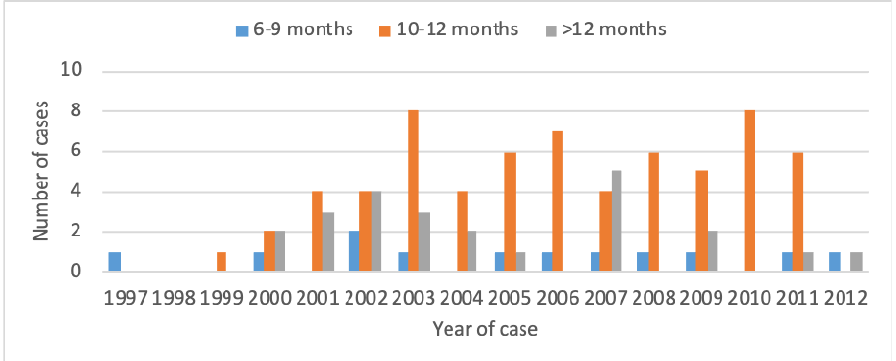
Figure 3. The distribution of patients with regard to duration of treatment for the study